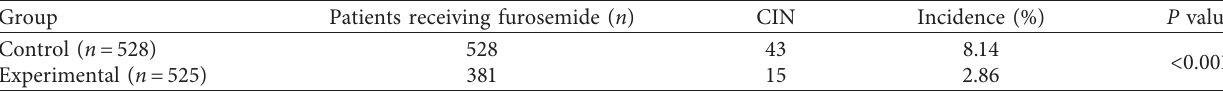
Table 2: Incidence of contrast-induced nephropathy in the control and experimental groups.